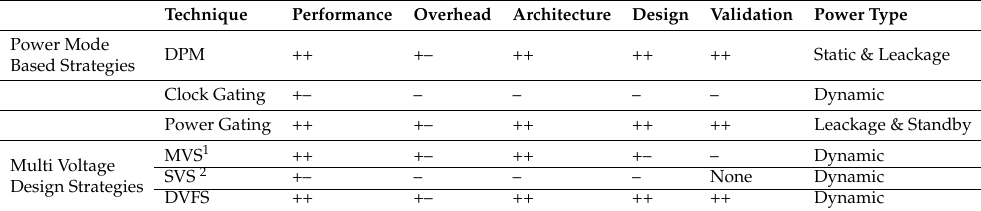
Table 1. Impact of energy saving technologies in